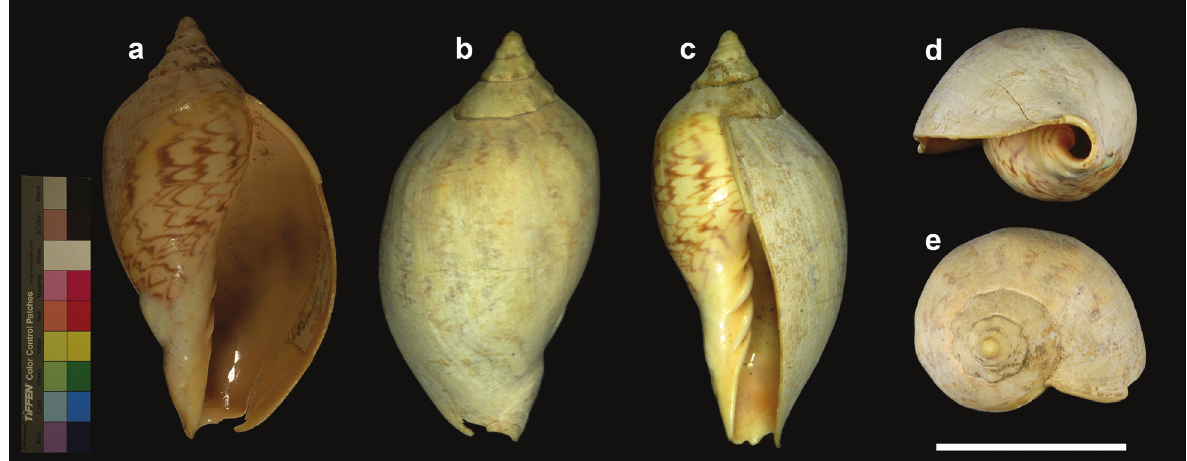
Figure 4. Voluta ambigua pseudotuberculata , holotype figured by Lahille (1895: pl. XI, fig. 6) a Apertural view b Dorsal view c Lateral view d Umbilical view e Apical view. Scale bar: 5 cm.